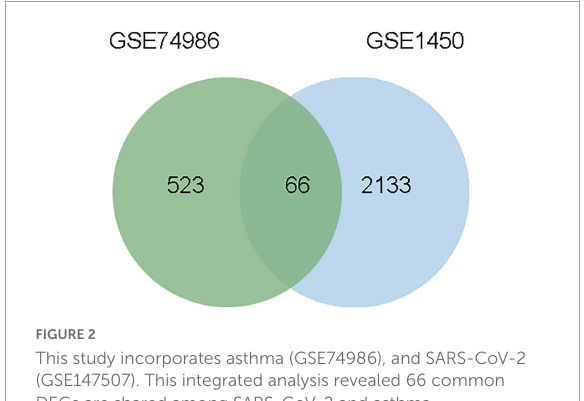
FIGURE2 This study incorporates asthma (GSE74986), and SARS-CoV-2 (GSE147507). This integrated analysis revealed 66 common DEGs are shared among SARS-CoV-2 and asthma.